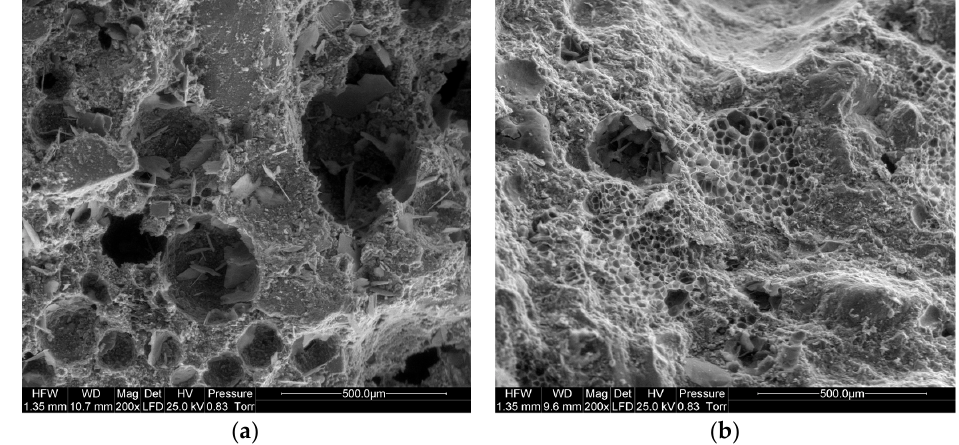
Figure 8. Microstructure of polymer-cement mortar containing waste perlite powder; content values of additions (in relation to cement mass): ( a ) perlite 10%, polymer 5%; ( b ) perlite 10%, polymer 15%.